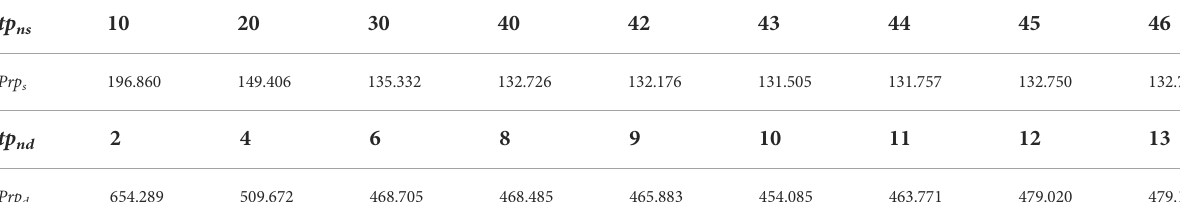
TABLE 2 Prp settings with various tp n .